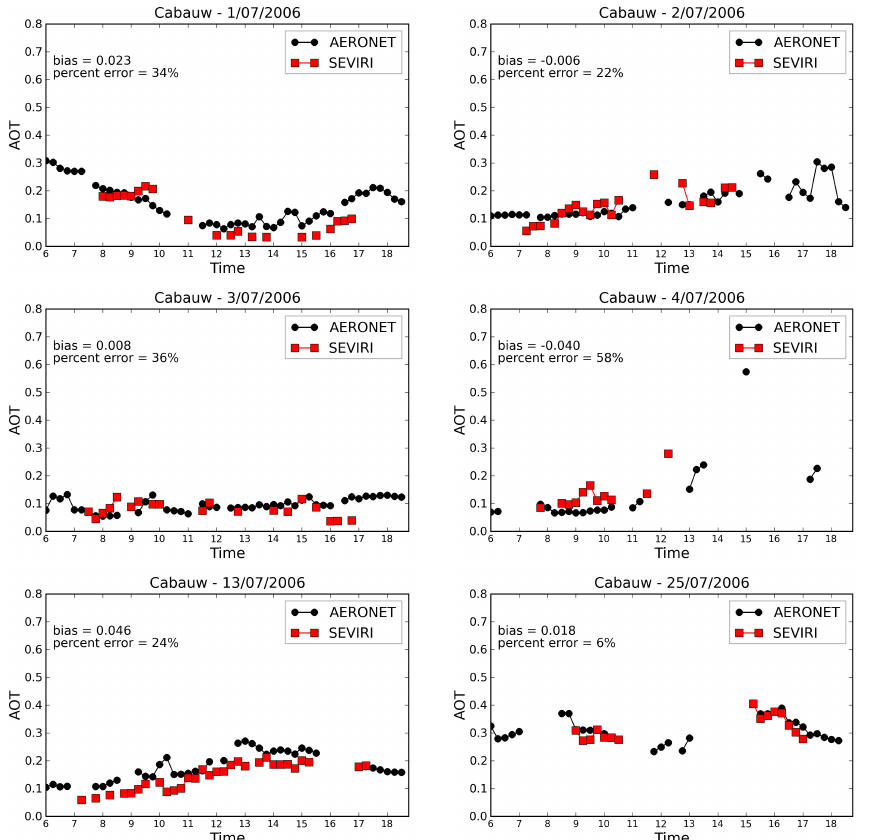
Fig. 5. Temporal evolution of the aerosol optical thickness above Cabauw for some days in July 2006: from 1 to 4 and on 13 and 25. The black line is AERONET and the red line is SEVIRI. The time scale is from 06:00 to 18:00 UTC and the AOT scale is from 0 to 0.7. The mean bias and the mean relative bias are indicated on each plot.